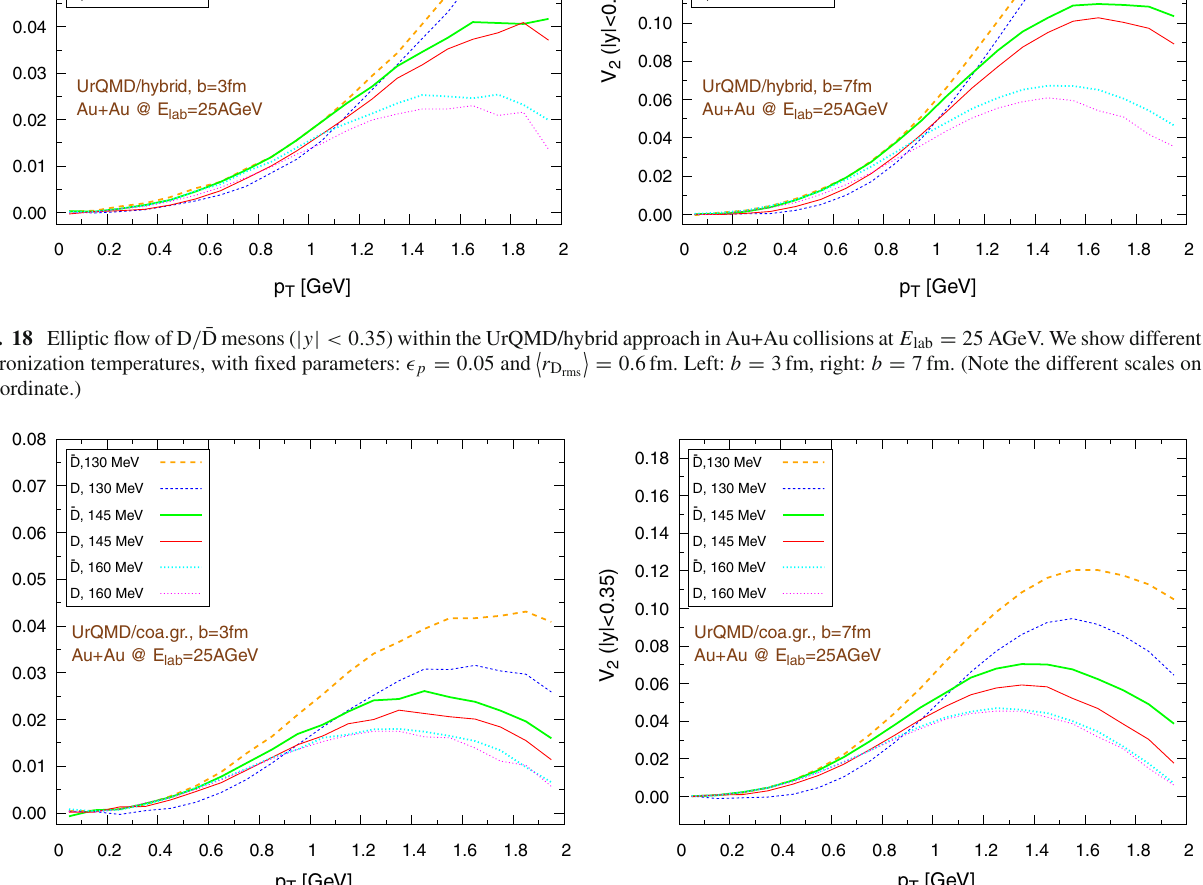
(cid:14) (cid:13) = 0 . 6fm. Left: b = 3fm, right: b = 7fm r D rms